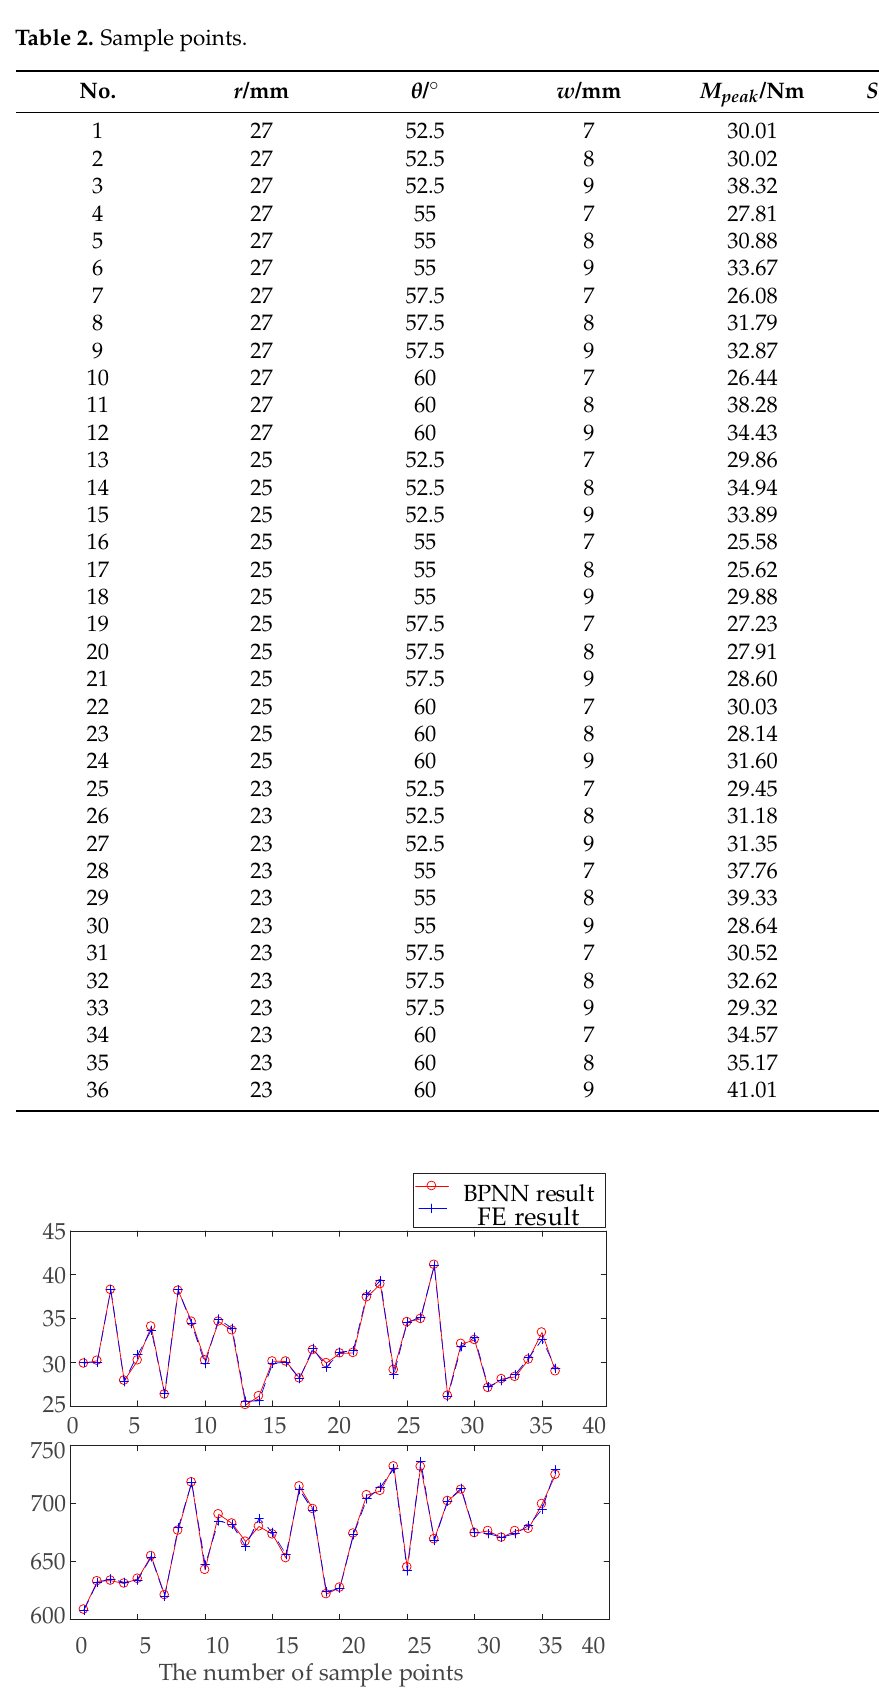
Figure 10. Fitting diagram of training sample points.